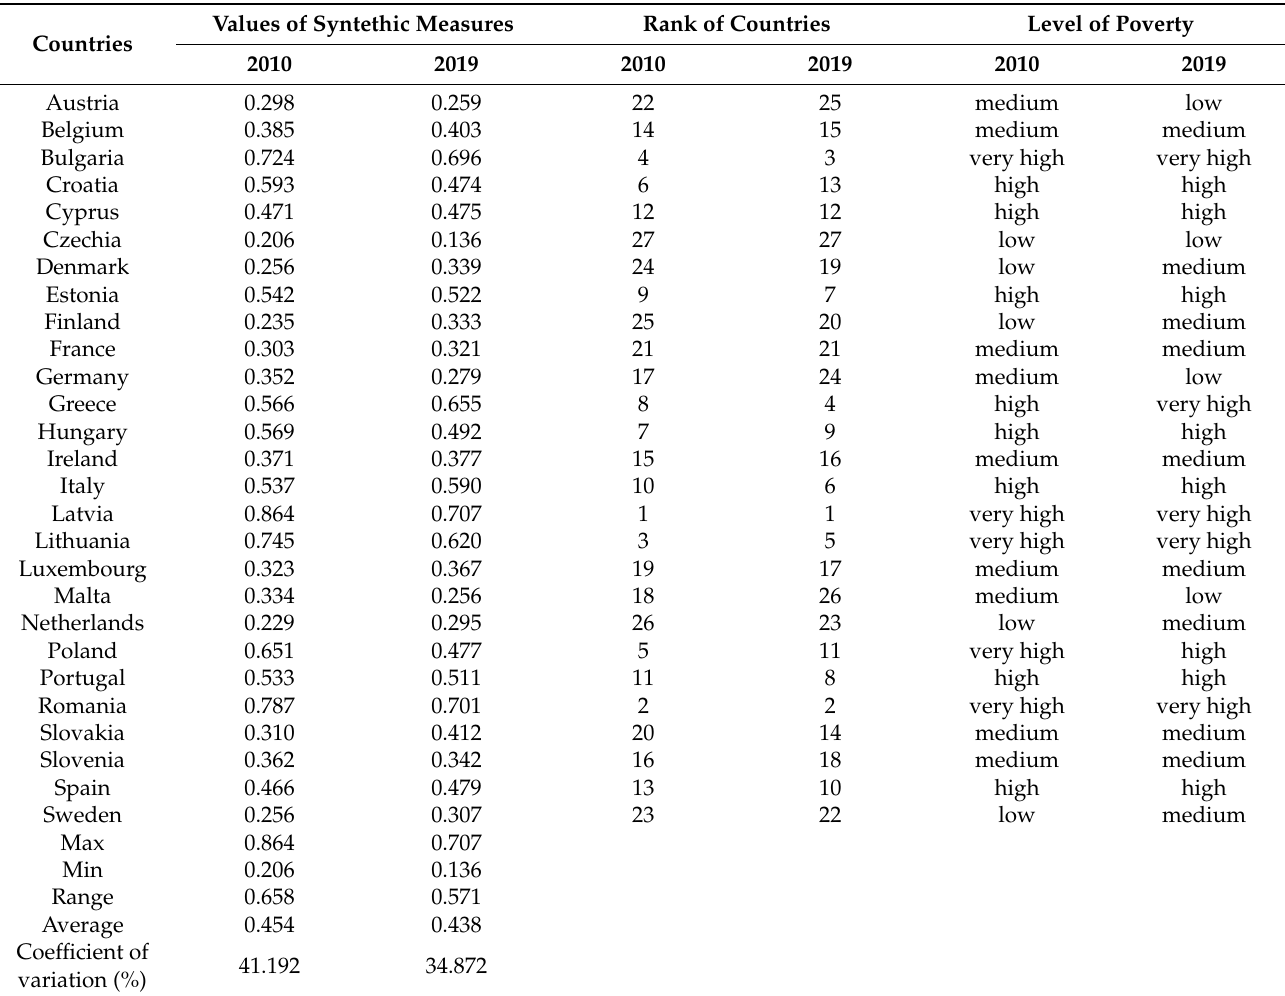
Table 3. Values of the synthetic measure and the rank of EU countries in terms of level of poverty in 2010 and